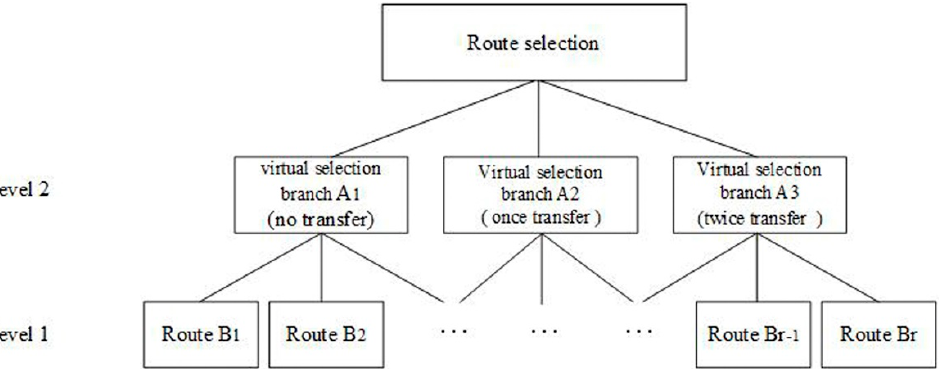
Figure 3. Structure of the double-nested logit model.